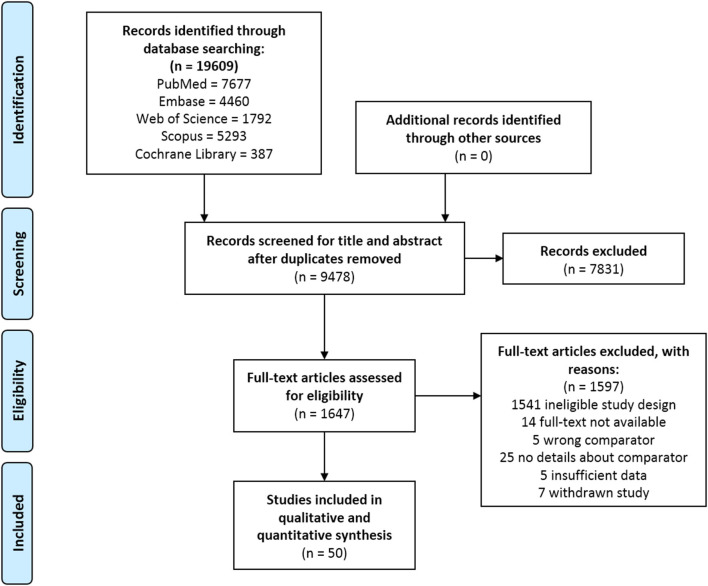
PRISMA flowchart.